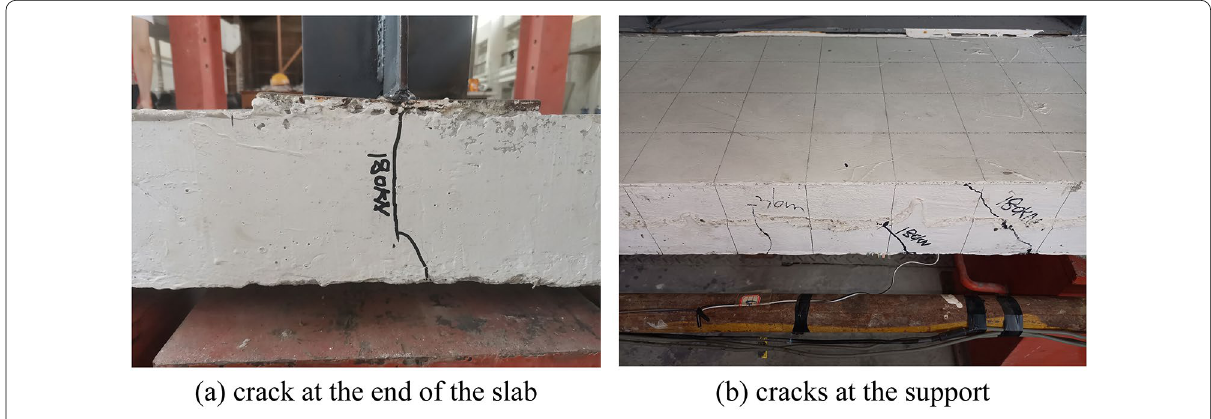
Fig. 9 Part of the crack pictures: a crack at the end of the slab, b cracks at the